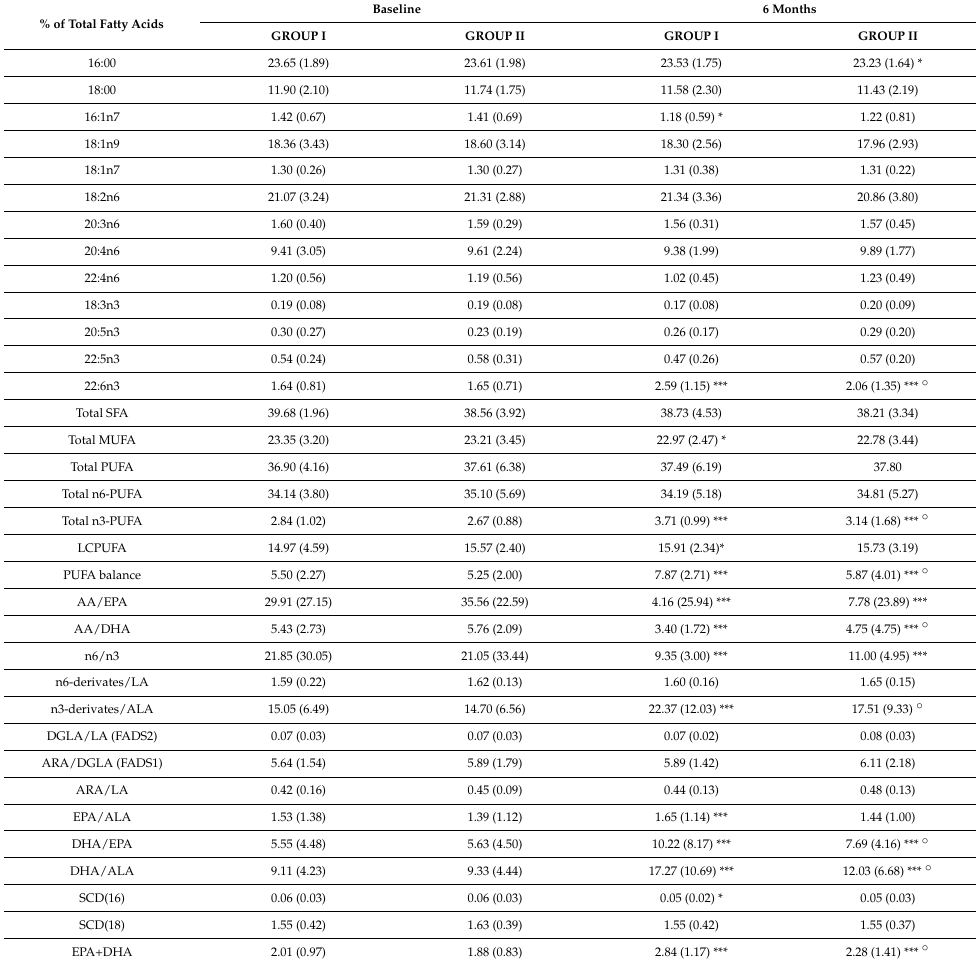
Table 4. Percentage of fatty acids distribution in vitamin D + DHA subjects (Group I) and vitamin D + wheat germ oil subjects (GROUP II) at baseline and after 6 months. Data are expressed as median